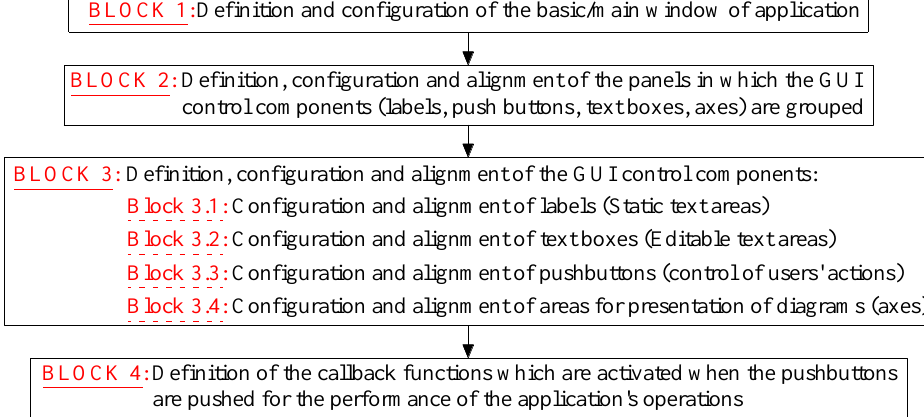
Figure 12. General description of the structure of the software application’s main function.